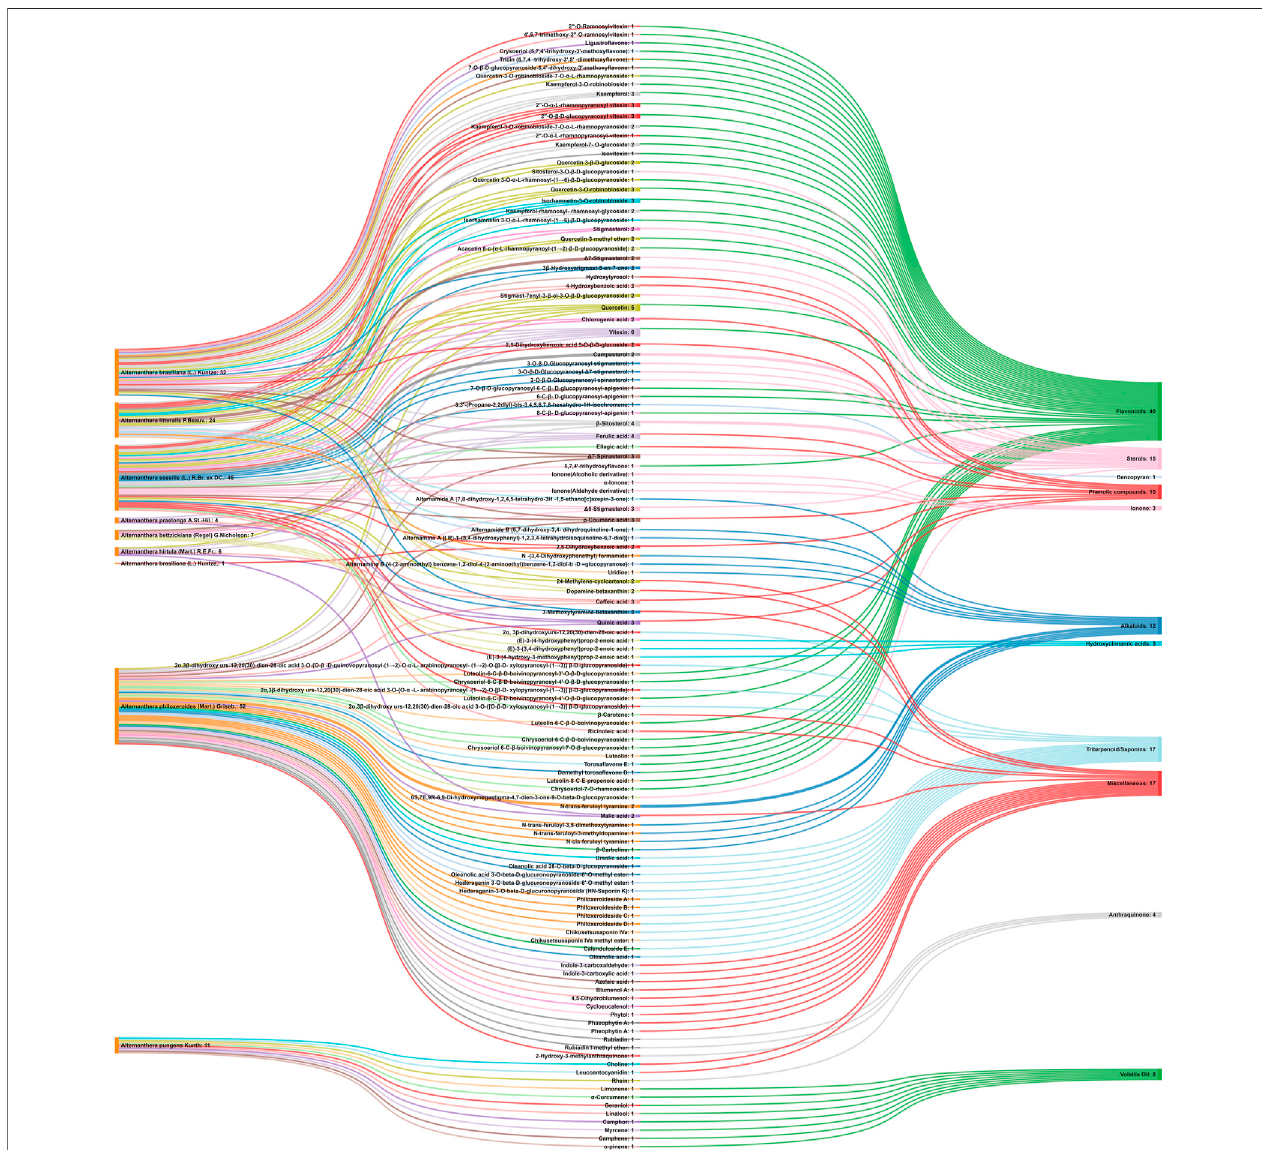
FIGURE 2 | Interaction analysis map to express association and relationship between phytochemical classi fi cations, compounds, and biological sources.